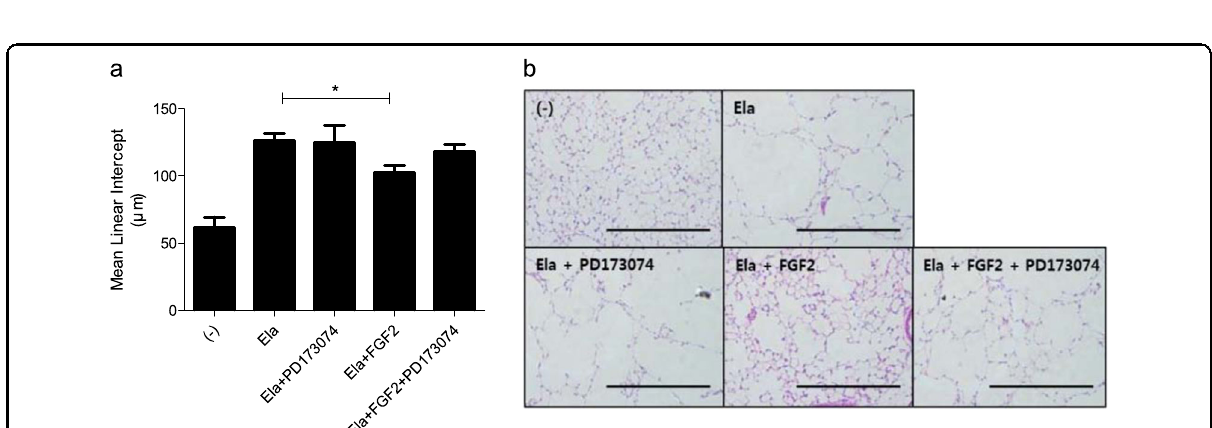
Fig. 5 Regenerative effects of FGF-2 on the elastase-induced emphysema model. The mice were intratracheally injected with 0.4 U of porcine elastase on day 0. Aliquots (10 pg) of FGF-2 and PD173074 were intranasally and intraperitoneally administered on days 7 – 13. The mice were killed on day 14. a MLI ( n = 4 – 6 per group). P -values were determined by the Mann – Whitney test; * p < 0.05. b Lung histology with H&E staining (scale bar = 1